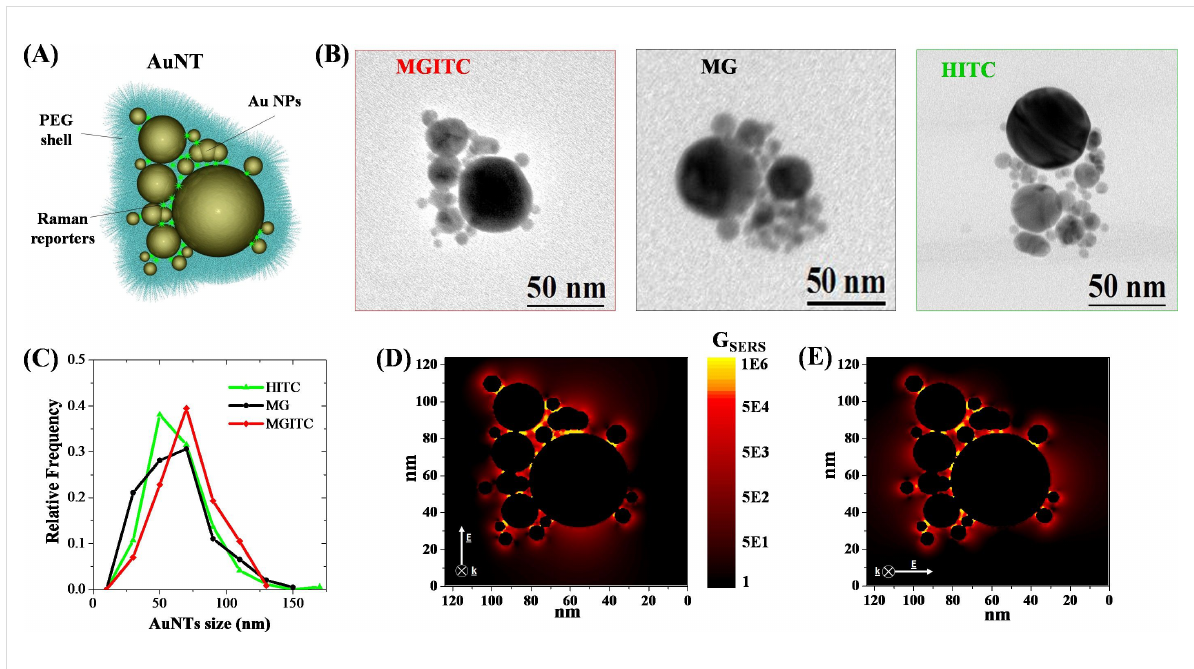
Figure 1: (A) Pictorial representation of the Au nanotag (AuNT), consisting of Au nanoparticles (NPs) aggregated by electrostatic interaction with cationic Raman reporters (either MG, MGITC or HITC), all coated with thiolated PEG. (B) Representative TEM images of MGITC, MG and HITC AuNTs. (C) Size histograms of HITC (green), MG (black) and MGITC (red) AuNTs, each one composed by several Au NPs. (D) G SERS bidimensional map for a AuNT embedded in PVA under excitation at 633 nm with light polarized along the y -axis. (E) G SERS bidimensional map for the same AuNT but with light polarized along the x